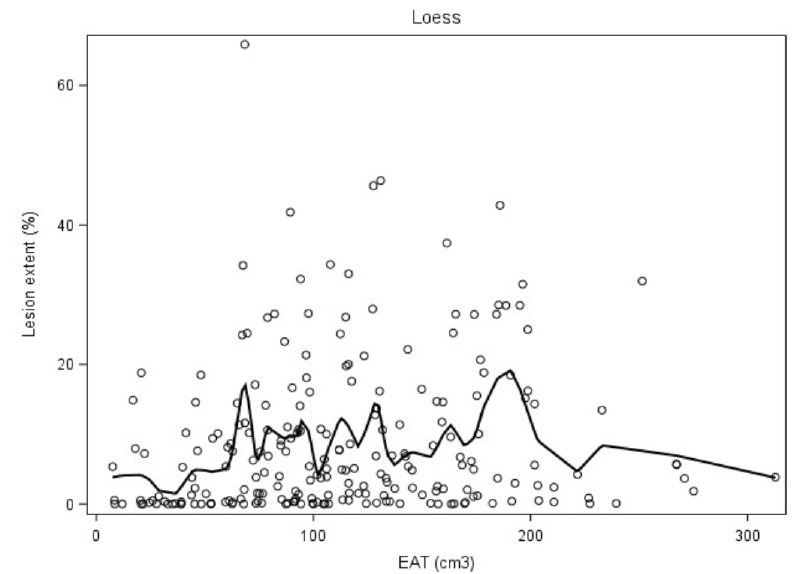
Figure A2. Correlation between COVID-19 lesion extent and EAT volume (n = 238). Lesion_Ext: COVID-19 lung lesion extent (%); EAT: epicardial adipose tissue volume (cm 3 ). Table A1. Correlation between epicardial adipose tissue volume and extent and COVID-19 clinical outcomes (n = 238). EAT: epicardial adipose tissue volume (cm 3 ); ICU: intensive care unit; Ext_EAT: epicardial adipose tissue extent (%), * Student t -test.